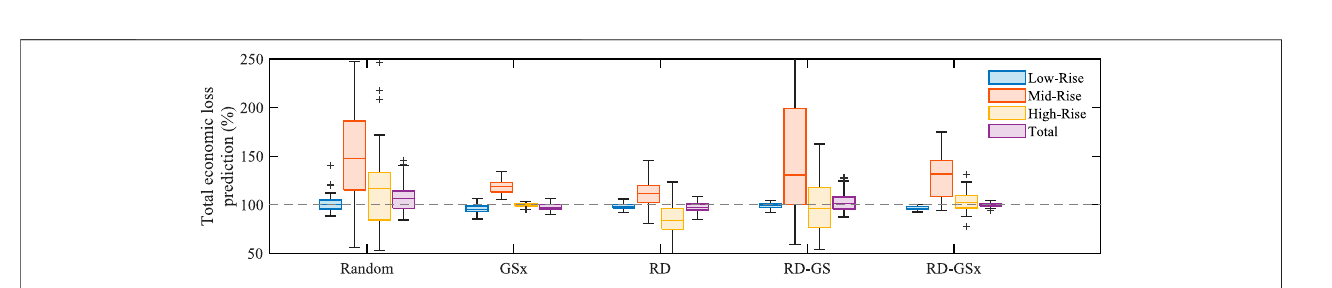
FIGURE 10 | Estimation of the economic loss predicted by each method as a percentage of the true economic loss.